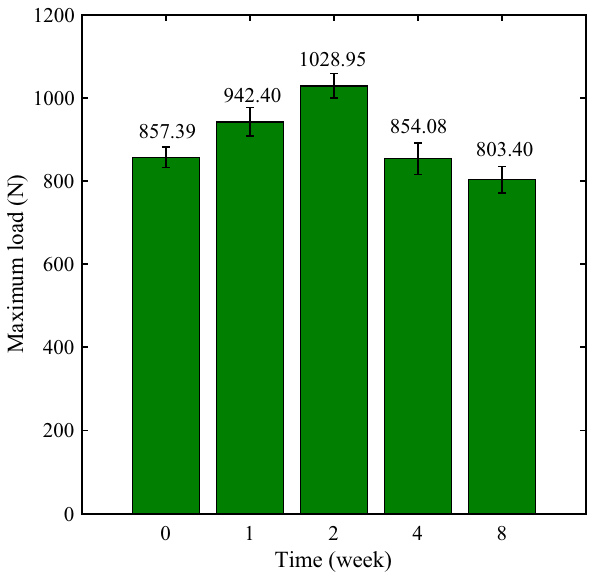
Figure 12: Maximum load of the samples exposed to an acidic environment at 25°C.